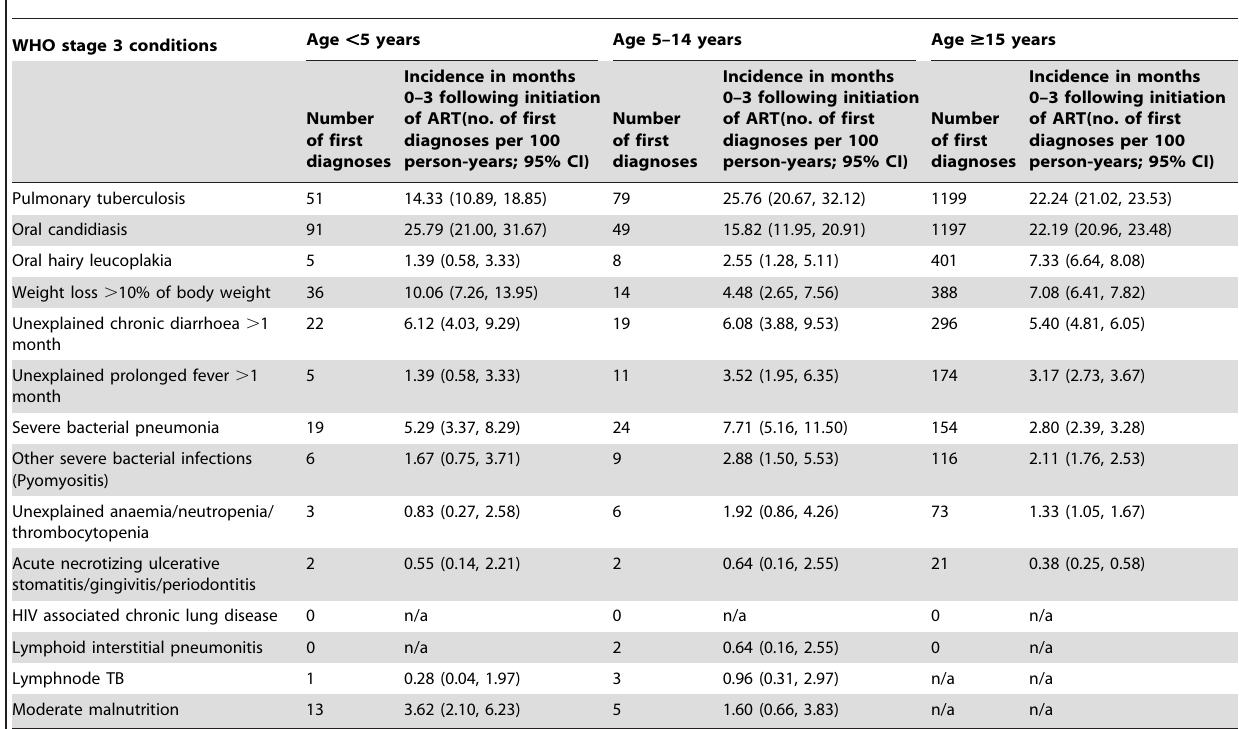
Table 6. Disease specific Incidence of WHO stage 3 conditions in months 0–3 following ART initiation by